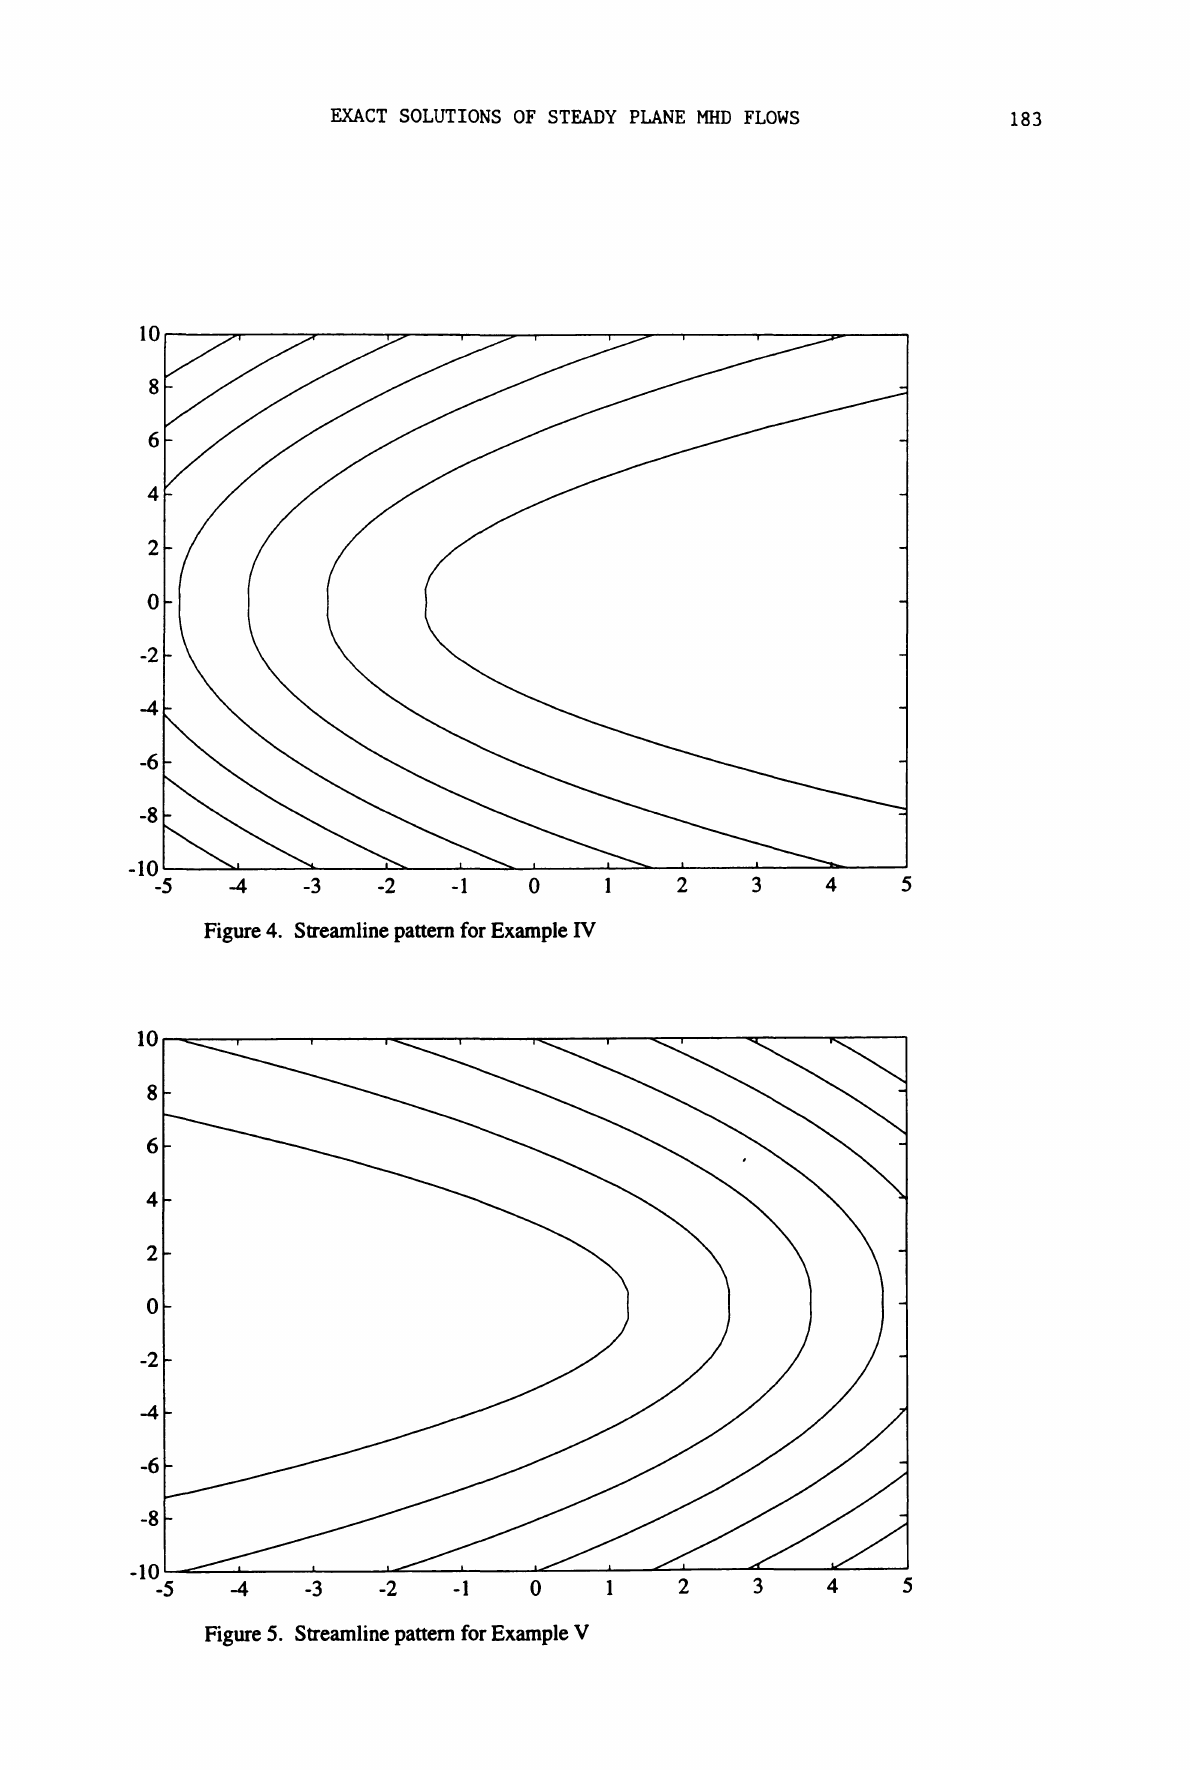
Figure 4. Streamline pattern for Example IV